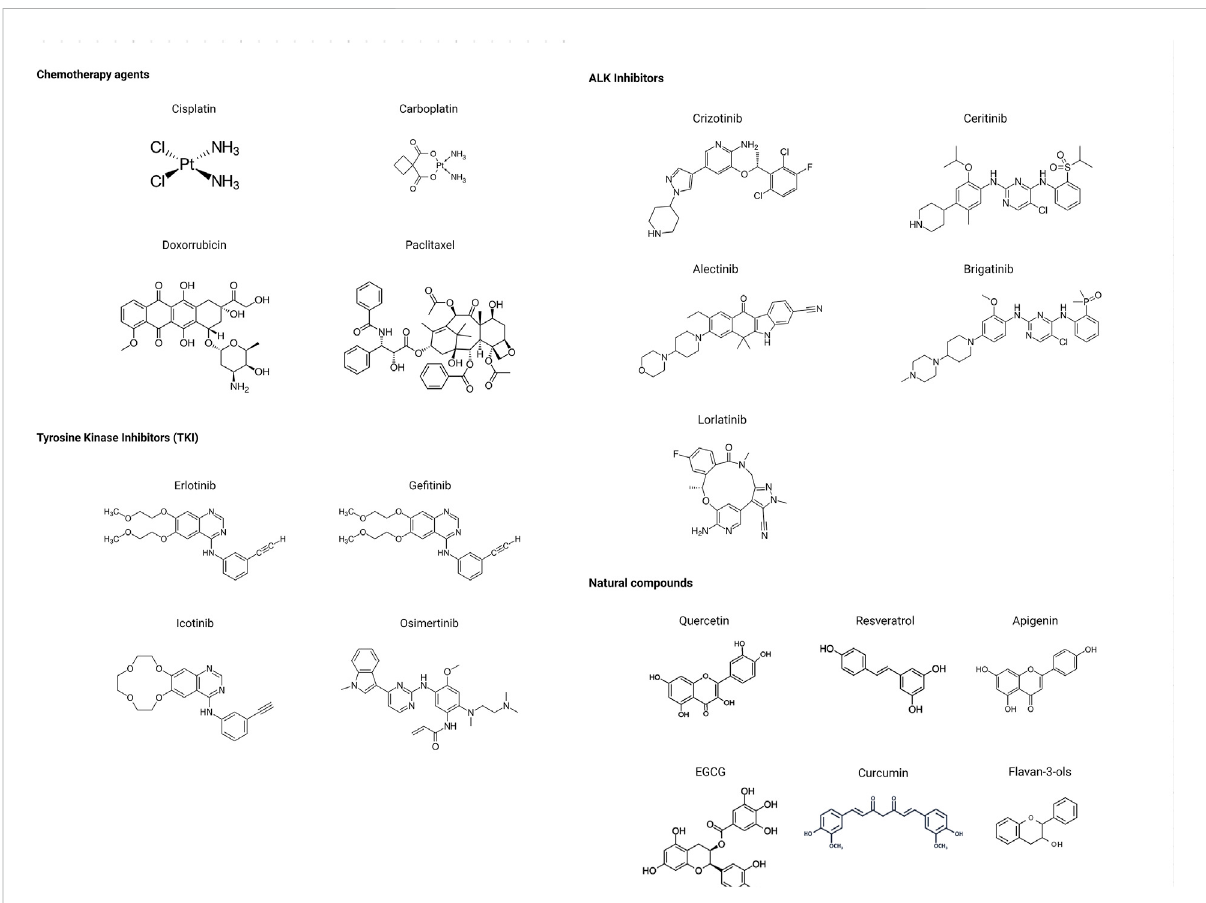
FIGURE 4 Chemical structure of chemotherapeutic agents, TKIs, ALK inhibitors, and phytochemicals discussed in the